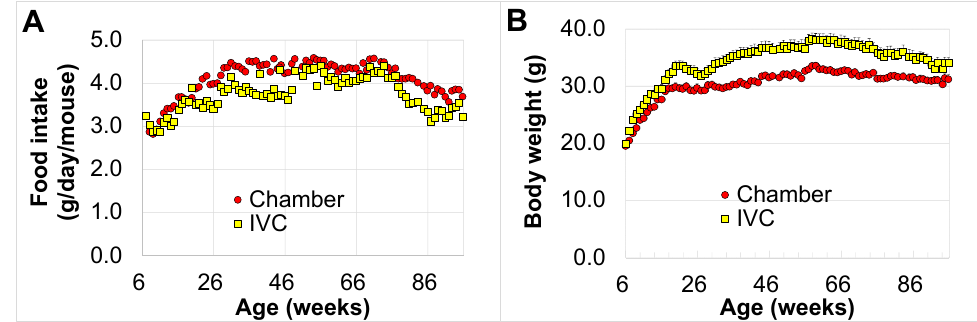
Figure 3. Changes in food consumption and body weight with aging in the chamber and IVC groups: ( A ) food consumption (g/mouse/day), ( B ) body weight.